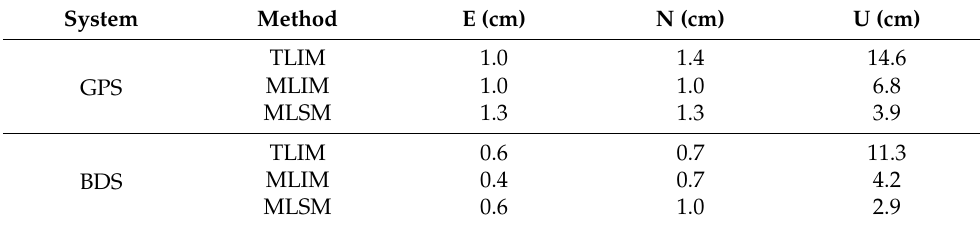
Table 2. GPS and BDS Positioning RMS statistical results for the rover station in dataset 2.